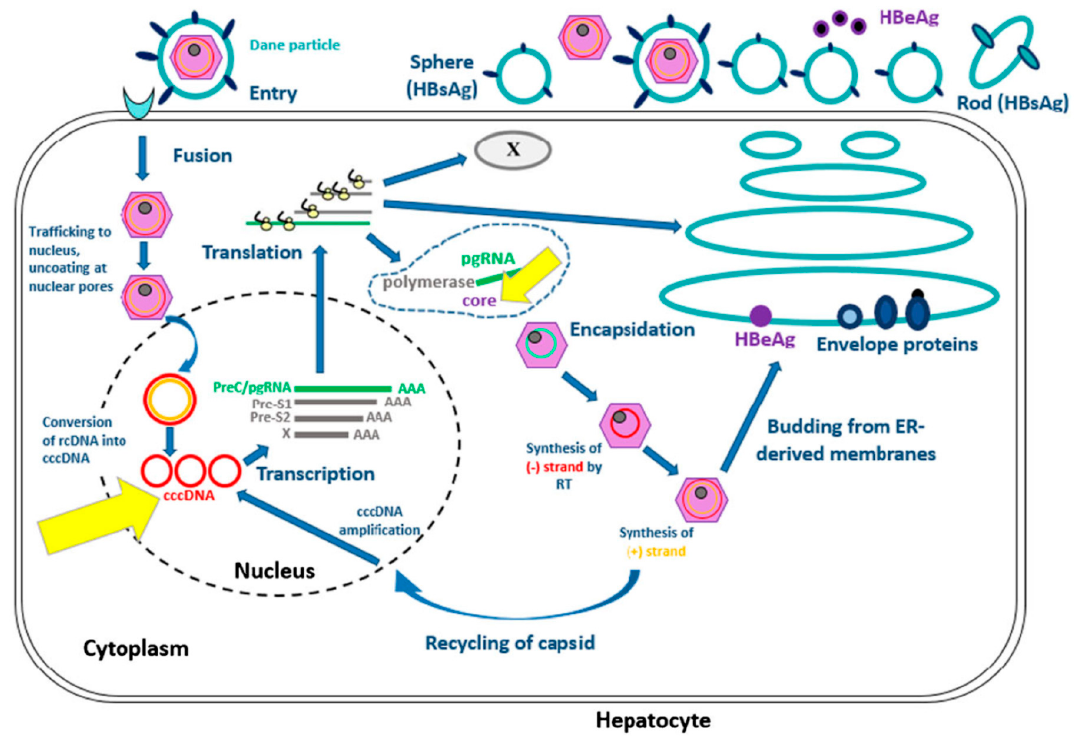
Figure 1. Hepatitis B virus life in hepatocyte [3,4]. Modified from Ait-Goughoulte M, Lucifora J, Zoulim F, Durantel D. Innate antiviral immune responses to hepatitis B virus. Viruses. 2010;2(7):1394-410.